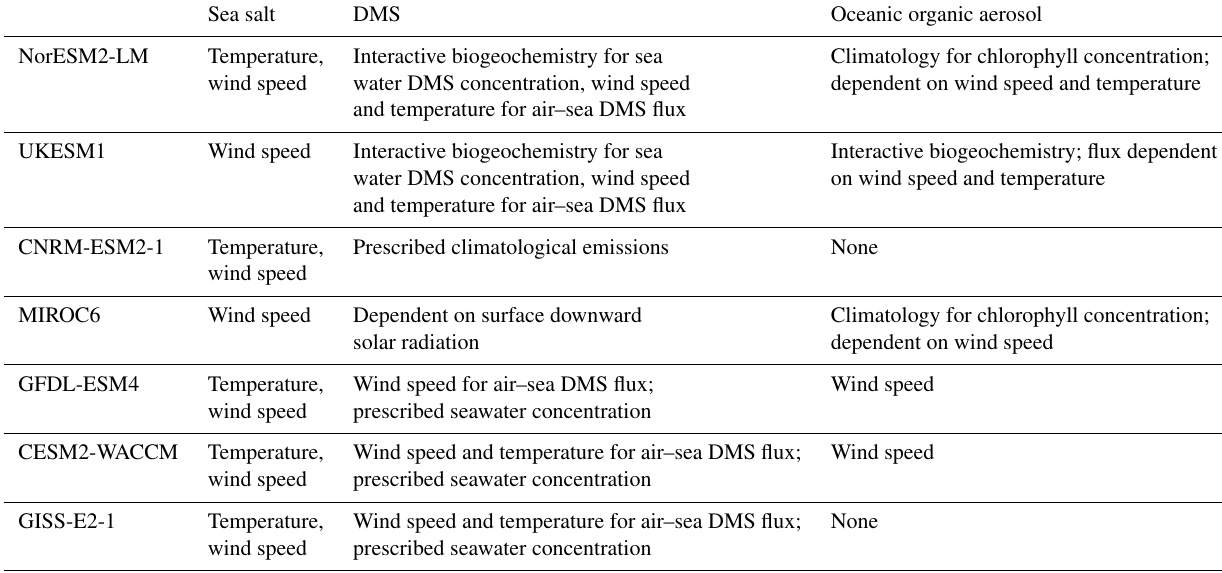
Table 4. Levels of complexity of marine emissions in the ESMs.